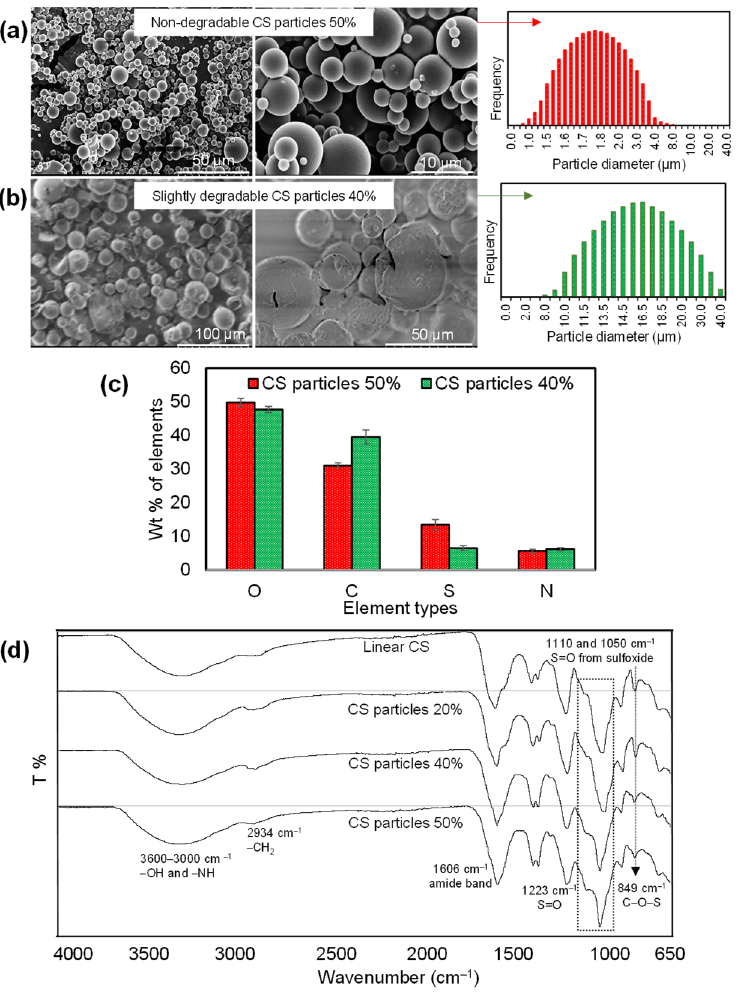
Figure 2. SEM images and size distribution of CS particles crosslinked at ( a ) 50%, ( b ) 40%, and ( c ) 20%. ( d ) FT-IR spectra of linear CS and its crosslinked forms, 20, 40, and 50% CS particles. (Size distribution was measured by ImageJ software according to SEM images.)